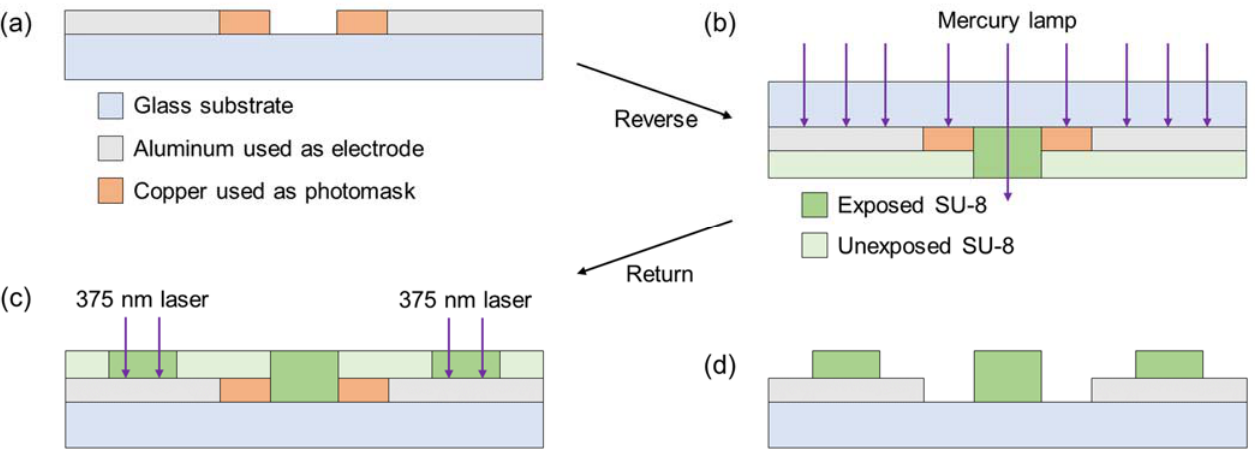
Figure 5. Illustrations of the patterning of insulators with backside exposure. ( a ) Patterning of the copper used as a photomask. ( b ) Backside exposure using the mask aligner. SU-8 covered with aluminum or copper is unexposed. ( c ) Selective exposure using the Maskless Aligner. ( d ) After developing SU-8, the copper photomask was etched.